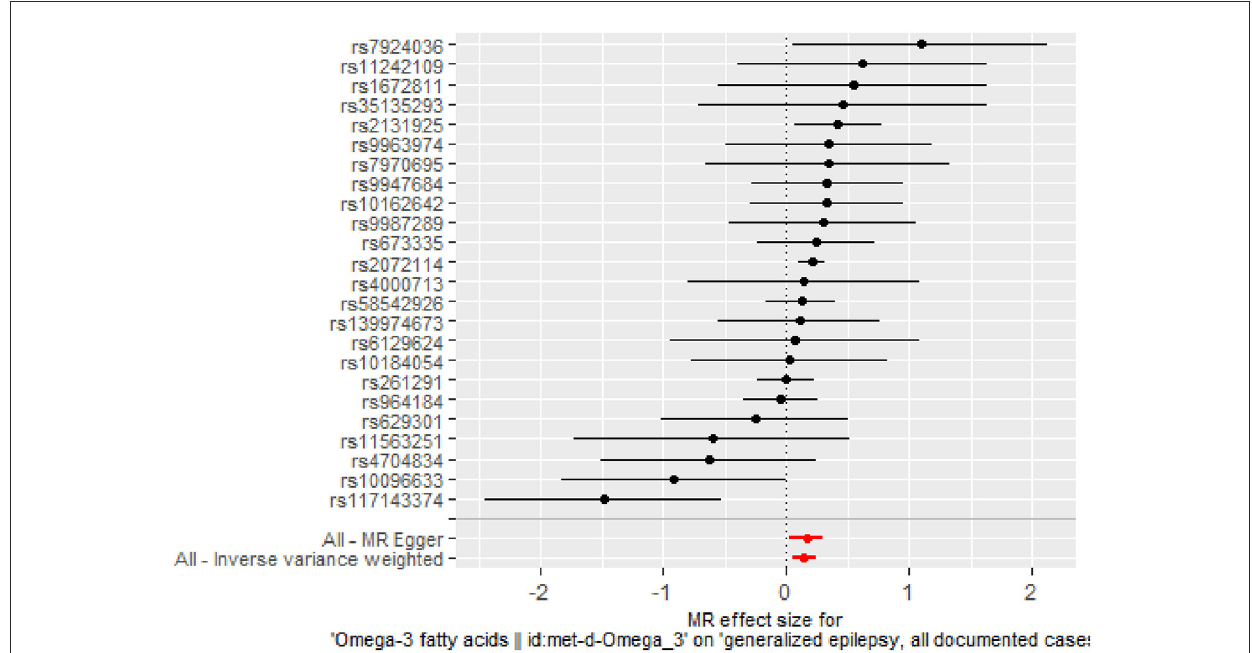
FIGURE2 Forest plot of MR analysis of the causal relationship between omega-3 fatty acids and generalized epilepsy. The x -axis shows the MR effect size of omega-3 fatty acids on generalized epilepsy. The y -axis shows the results of the analysis for each SNP.